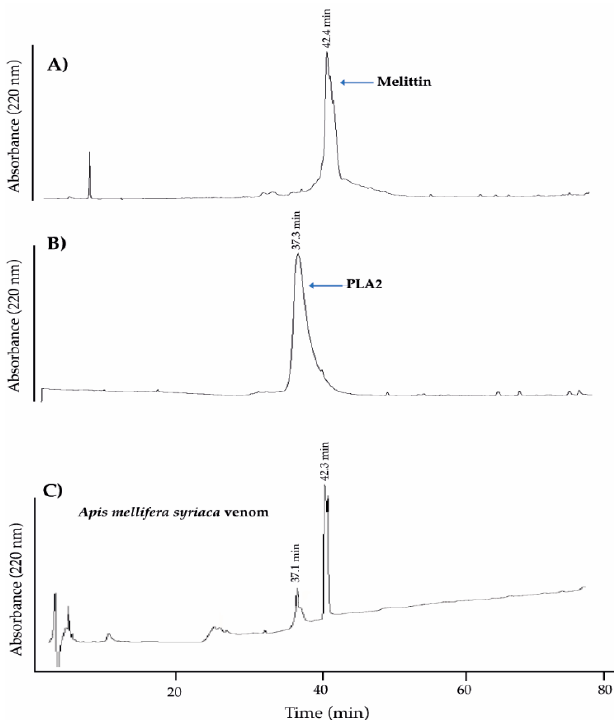
Figure 1. High-pressure liquid chromatography (HPLC) chromatograms showing reverse-phase C18 fractionation of ( A ) standard MEL, ( B ) standard PLA2, and ( C ) A. mellifera syriaca crude venom. The two standard molecules MEL and PLA2 were eluted individually at the same retention times as those presented in the A. mellifera syriaca venom, validating their conformational properties.